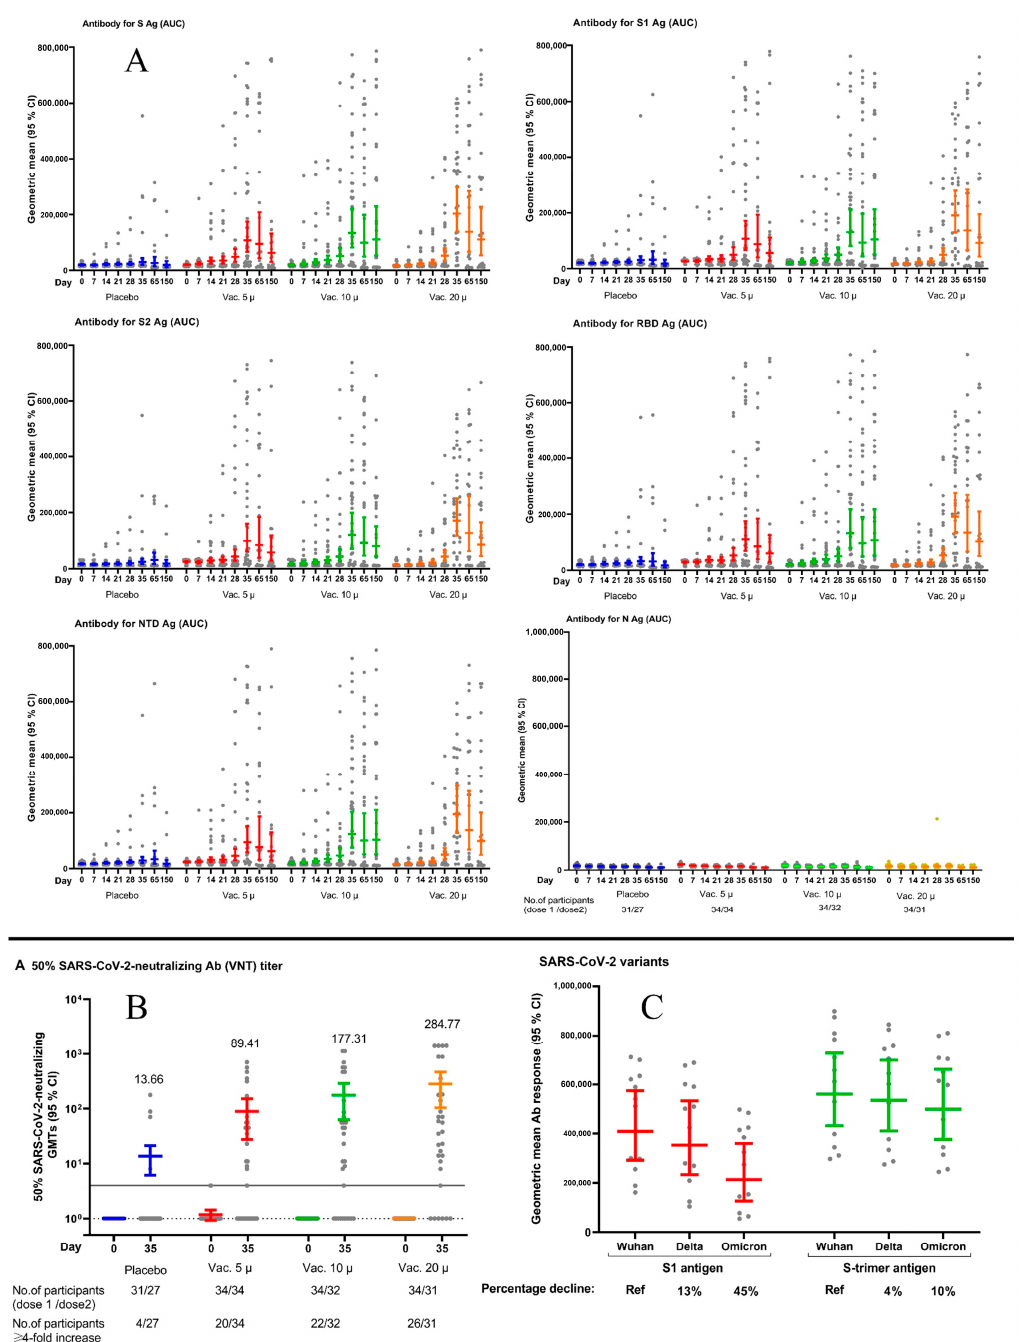
Figure 3. ( A ) Scatter diagram of specific IgG antibody responses (AUC) against S, S1, S2, RBD, NTD, and N (Nucleocapsoid) antigen (SARS-CoV-2 variant in Wuhan) in the intervention groups over the predefined study time schedule. Geometric means and 95% confidence intervals have been shown on the diagram. ( B ) Scatter diagram of serum neutralizing antibody titers (cVNT with the SARS-CoV-2 variant in Wuhan) in the intervention groups over the predefined study time schedule. Geometric mean titers giving 50% serum neutralization and 95% confidence intervals are shown in the diagram. The horizontal solid line is the cut-off titer of 1:4. The horizontal dotted line is the baseline titer. ( C ) ELISA-specific IgG antibody responses against s1 and s-trimer antigenic components by changing SARS-CoV-2 variants over time (SARS-CoV-2 variant in Wuhan, Delta, and Omicron) in the 10 µ g vaccine